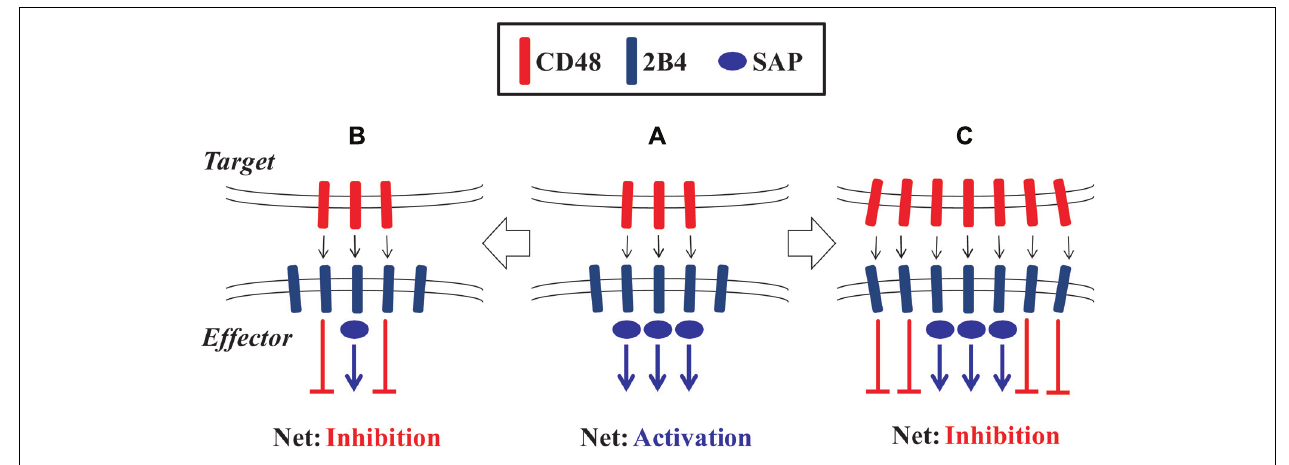
FIGURE 1 | Molecular model of the dual-function of 2B4. (A) Engagement of 2B4 by CD48 in the presence of sufficient SAP protein leads to activation of NK or CD8T cell effector cells. (B) Insufficient levels of SAP protein leads